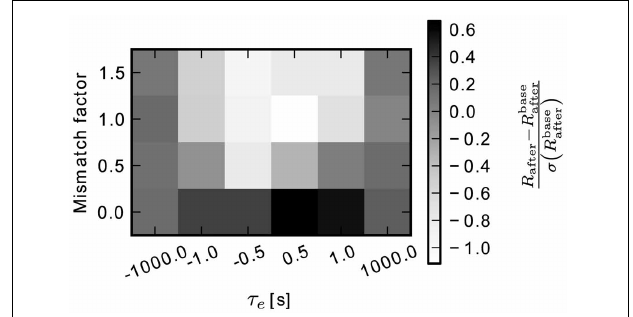
FIGURE 10 | Difference of final reward to the baseline simulation R after – R base after in units of the baseline standard deviation. The varied parameters are the average time constant and the amount of mismatch between